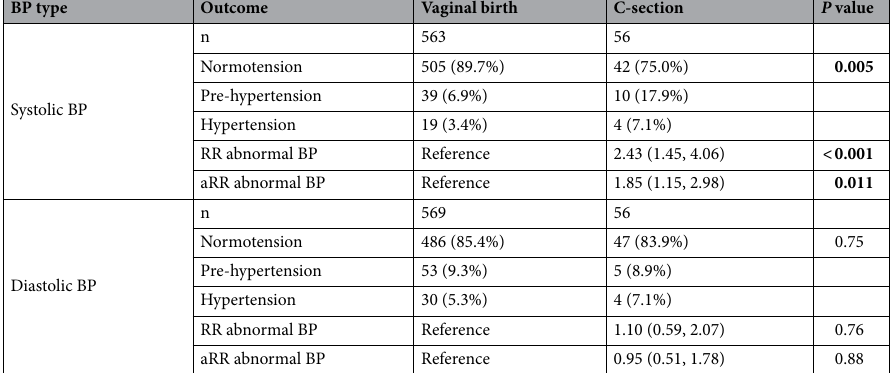
Table 4. Rates of blood pressure abnormalities in a cohort of young adults in Chiang Mai (Thailand) according to delivery mode. Systolic pre-hypertension, SBP ≥ 130 but < 140 mmHg; systolic hypertension, SBP ≥ 140 mmHg; abnormal systolic BP, SBP ≥ 130 mmHg; diastolic pre-hypertension, DBP ≥ 85 but < 90 mmHg; diastolic hypertension, DBP ≥ 90 mmHg; and abnormal diastolic BP, DBP ≥ 85 mmHg. Rates data are n (%); RR data are relative risks and the respective 95% confidence intervals (CI); aRR data are adjusted RR and respective 95% CI, adjusted for sex, gestational age at delivery, and mother’s pregnancy- induced hypertension (yes vs no). Systolic and diastolic BP data were missing for 12 and 6 participants born vaginally, respectively, and for one participant born by C-section. aRR adjusted relative risk, BP blood pressure, C-section caesarean section, RR relative risk. P values that are statistically significant (at p < 0.05) are shown in